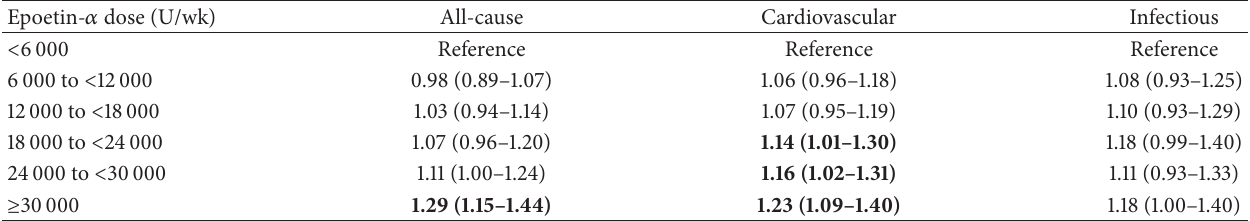
Table 4: Adjusted odds ratio (95% confidence interval) for mortality by weekly epoetin- 𝛼 doses in incident patients.